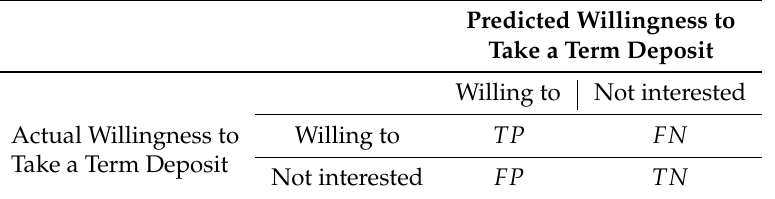
Table 5. Confusion